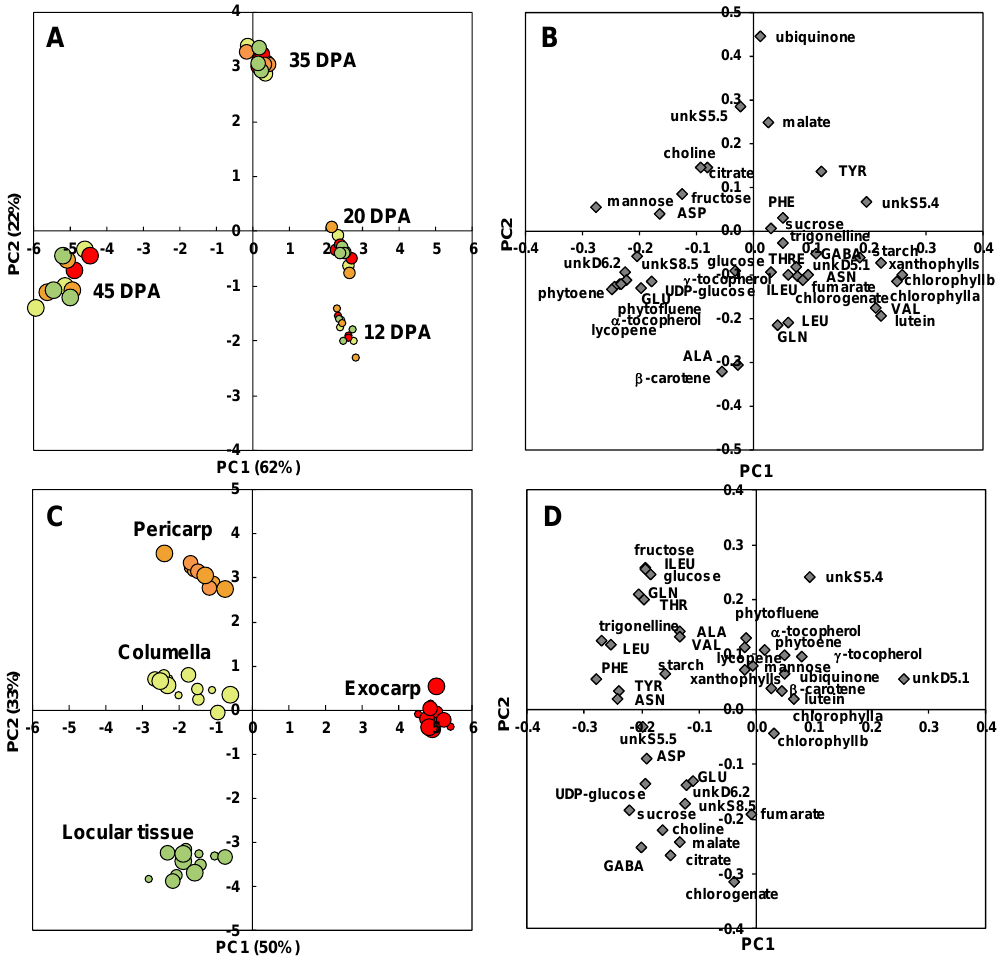
Figure 6. ANOVA-PCA of absolute values of 39 metabolites and starch measured by 1 H-NMR, LC-DAD or enzymatic analyses in four tomato fruit tissues at four stages of development. ( A ) PC1 × PC2 scores plot for developmental stage e ff ect. ( B ) PC1 × PC2 loadings plot for developmental stage e ff ect. ( C ) PC1 × PC2 scores plot for tissue e ff ect. ( D ) PC1 × PC2 loadings plot for tissue e ff ect. Exocarp in red, Mesocarp with endocarp in orange, Columella with placenta in yellow, Locular tissue in light green.